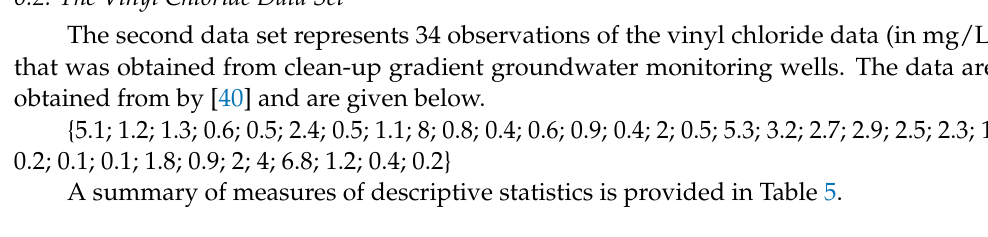
The second data set represents 34 observations of the vinyl chloride data (in mg/L) that was obtained from clean-up gradient groundwater monitoring wells. The data are obtained from by [40] and are given below.